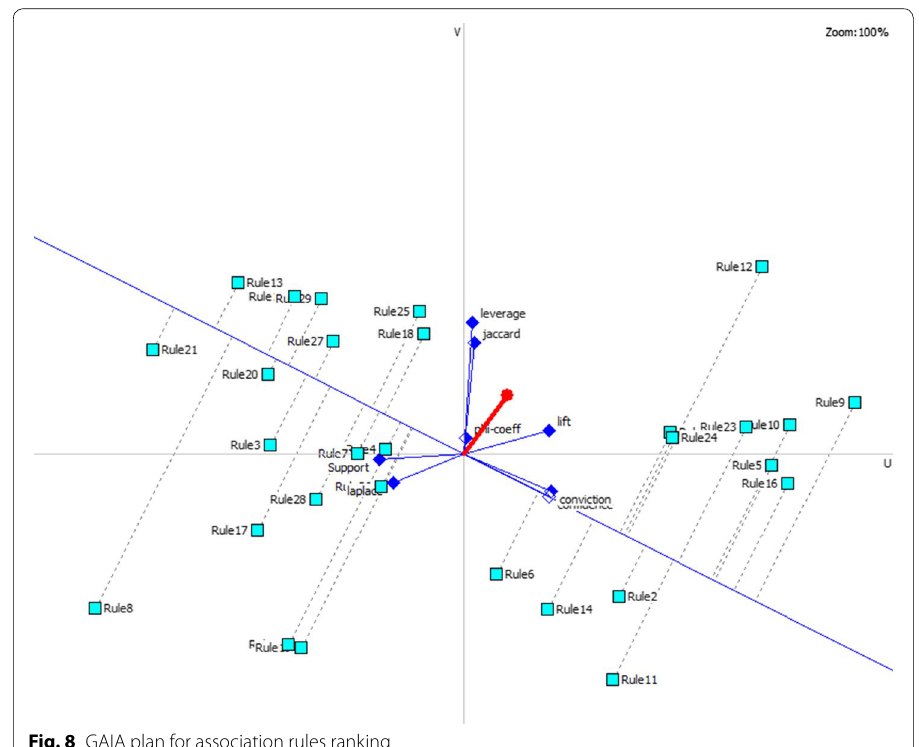
Fig. 8 GAIA plan for association rules ranking